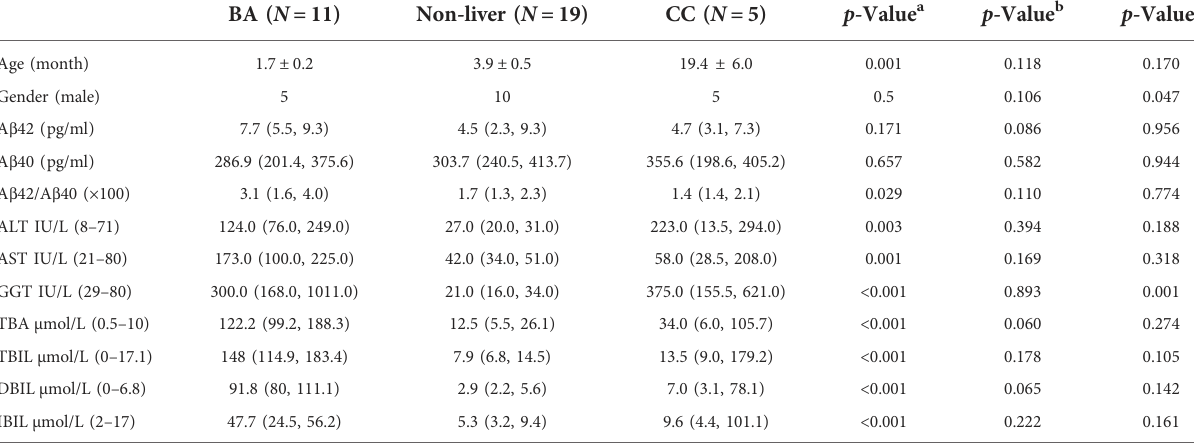
Values in parenthesis indicated normal range of hepatic function indicators. Levels of A β peptides and hepatic function indicators in patients were shown as Median (Q1, Q3). Age was shown as mean±SEM. BA, biliary atresia; CC, choledochal cysts; ALT, alanine aminotransferase; AST, aspartate aminotransferase; GGT, γ -glutamyl transpeptidase; TBA, total bile acid; TBIL, total bilirubin; DBIL, direct bilirubin; IBIL, indirect